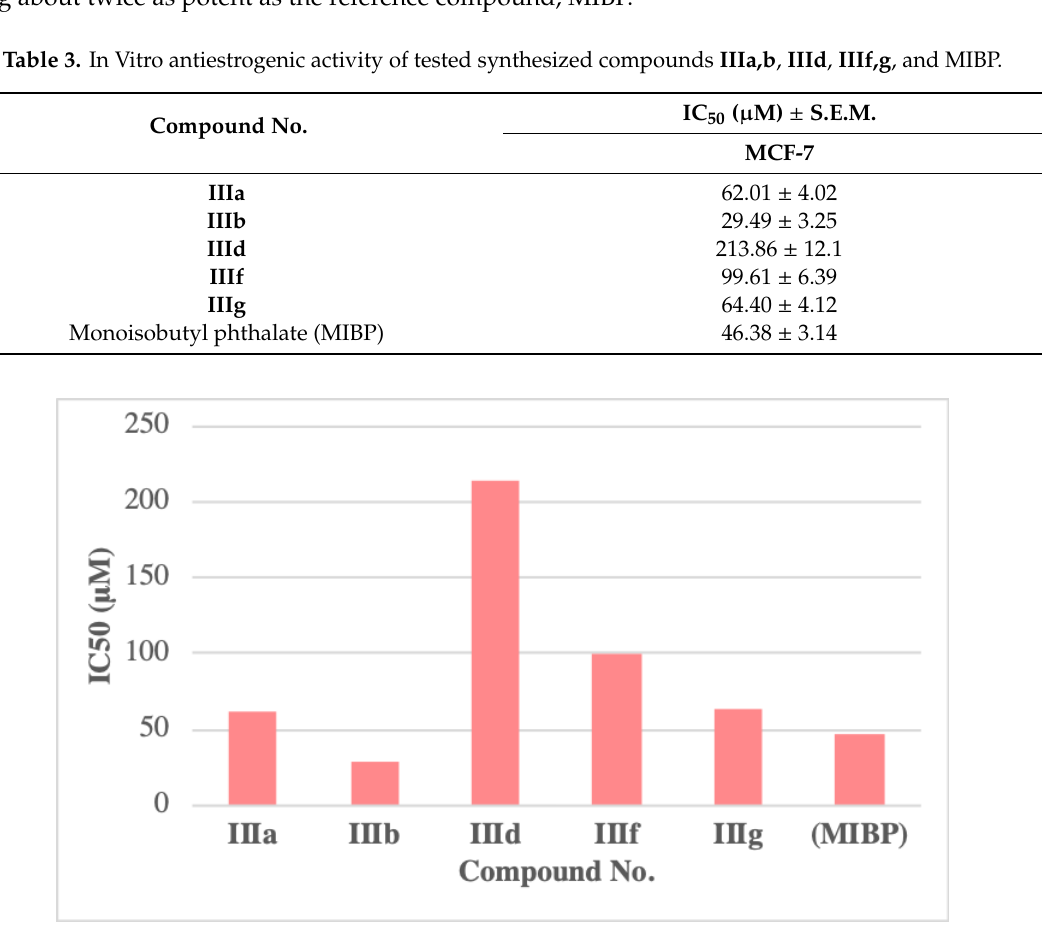
Table 4. Aromatase inhibition activity of the selected synthesized compounds and letrozole. Compound No.